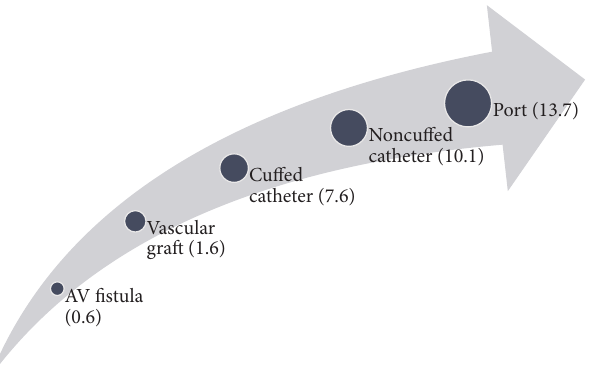
Figure6:Depictingvascularaccessinfectionratebytypeofvascular